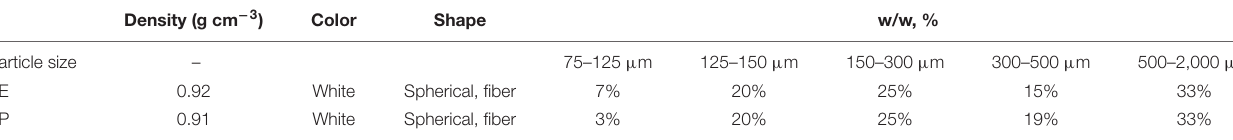
TABLE 2 | Density, particle sizes, and morphology of polyethylene (PE) and polypropylene (PP) used in this study.